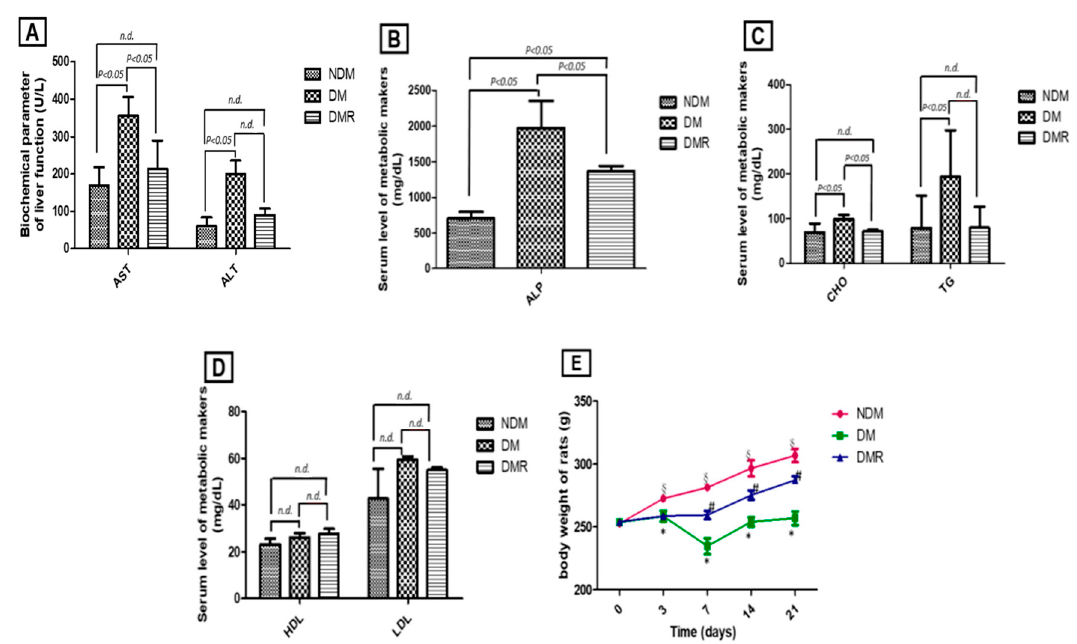
Figure 1. Histogram of serum biochemical markers and metabolic functions ( A – D ), including AST and ALT ( A ), ALP ( B ), CHO and TG ( C ), HDL and LDL ( D ). Line chart of 21 days of continuous observation of weight change ( E ). * p < 0.05 hyperglycemic (DM) compared with the normal (NDM) group, § p < 0.05 hyperglycemic with rutin (DMR) compared with the NDM group, # p < 0.05 DMR compared with the DM group, n.d. means no difference ( p > 0.05).